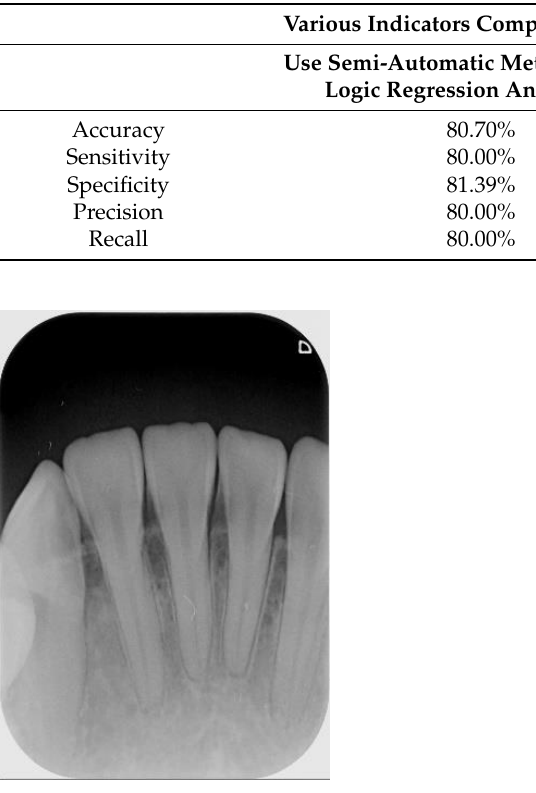
Table 4. Accuracy (%) comparison.